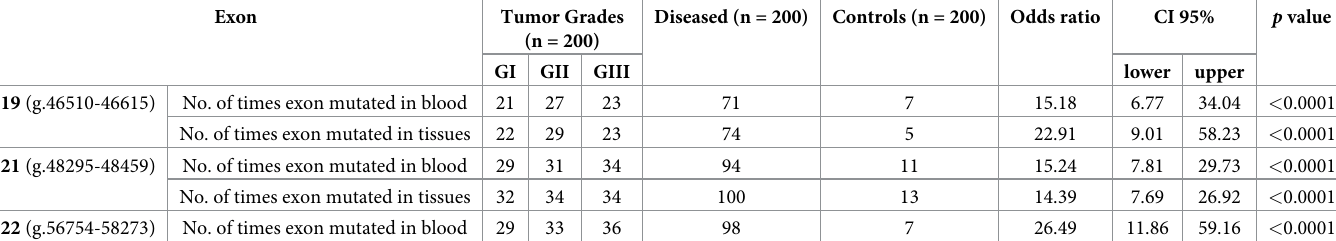
Table 1. Mutation frequencies in various exons of Rbl2/p130 gene among various breast cancer cohorts.